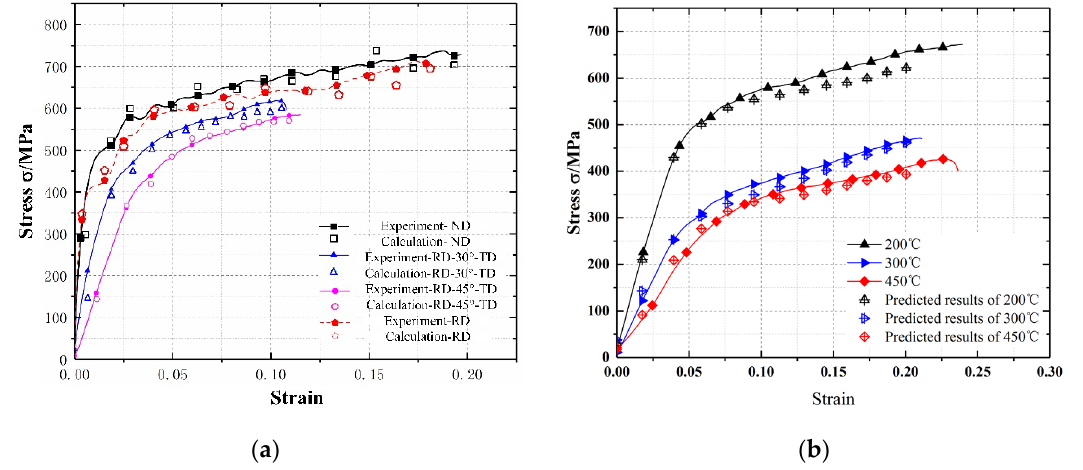
Figure 11. Stress–strain prediction curves under different loading conditions, ( a ) Predicted stress– strain curve at a strain rate of 0.2 × 10 4 s − 1 . ( b ) Predicted stress–strain curves of the 45° specimens at different temperatures .